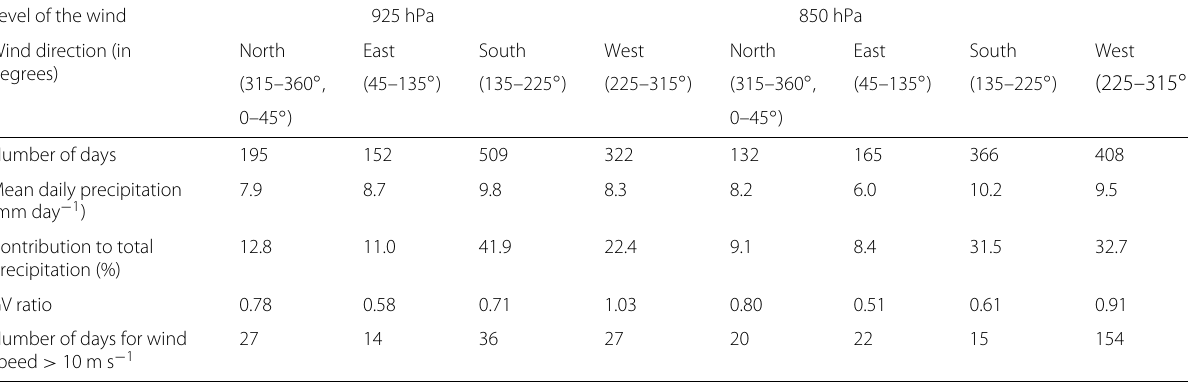
Table 1 Statistics of wind frequency, precipitation, and its reproducibility by the GSMaP with respect to the VnGP classified into four wind direction